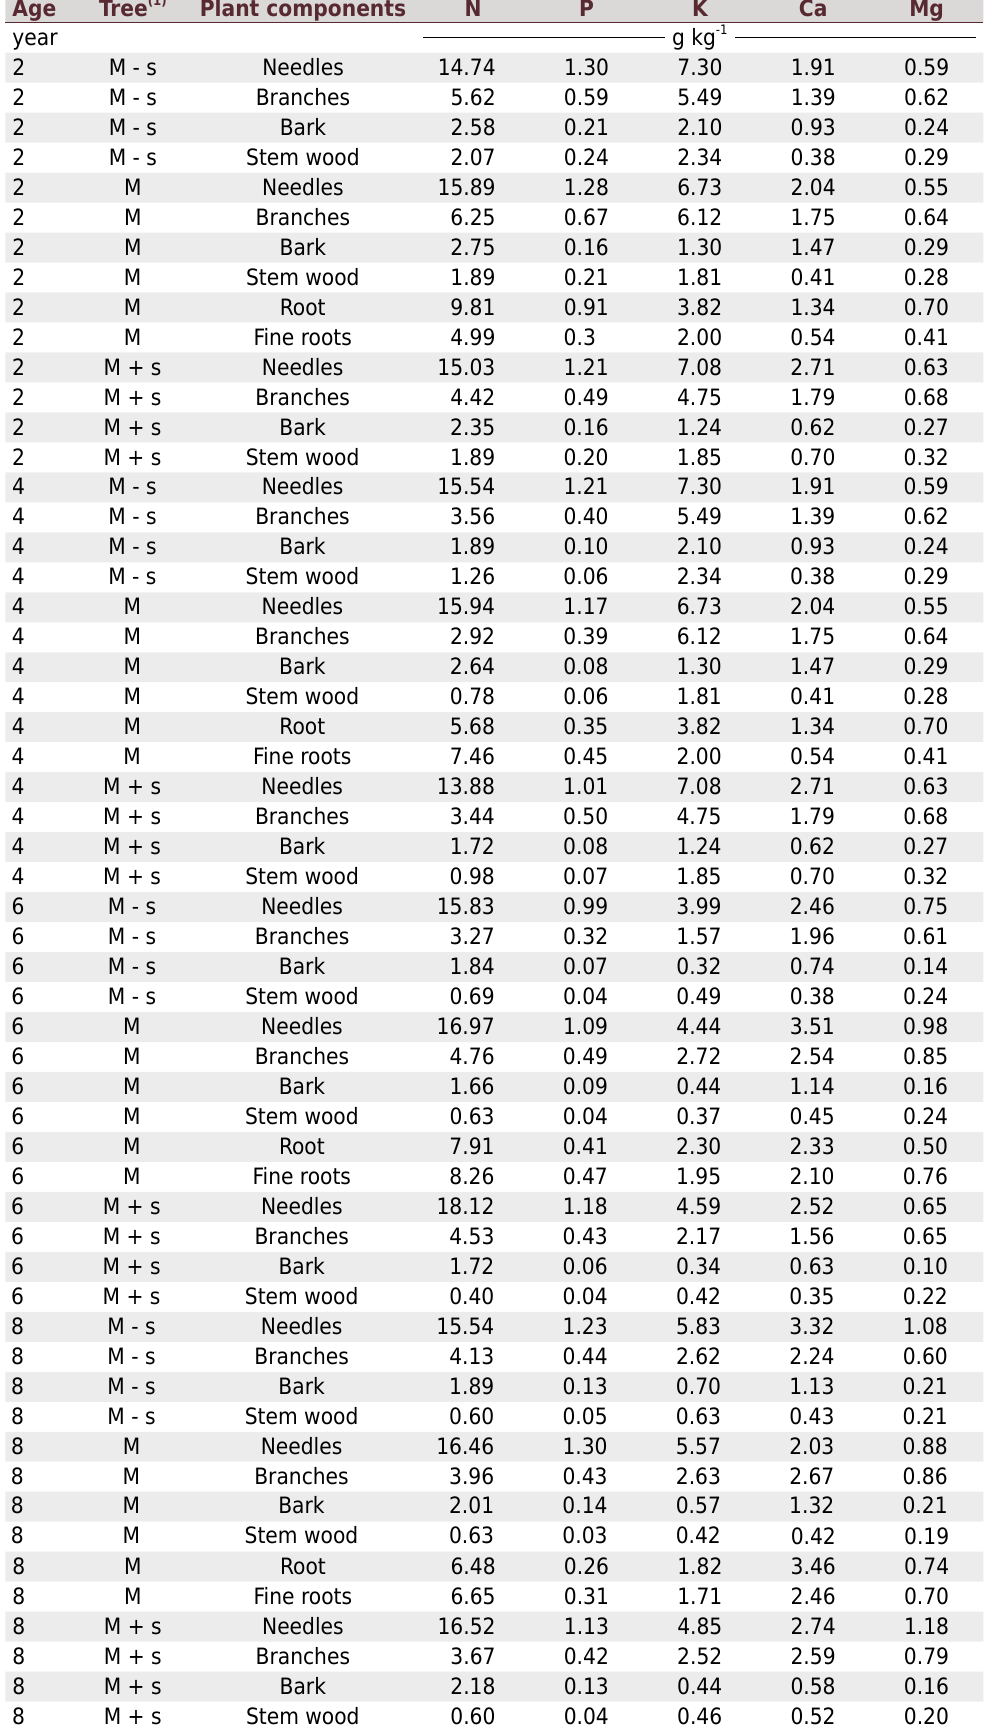
Table 5. Nutrient content in P. taeda in Southern Brazil Age Tree (1) Plant